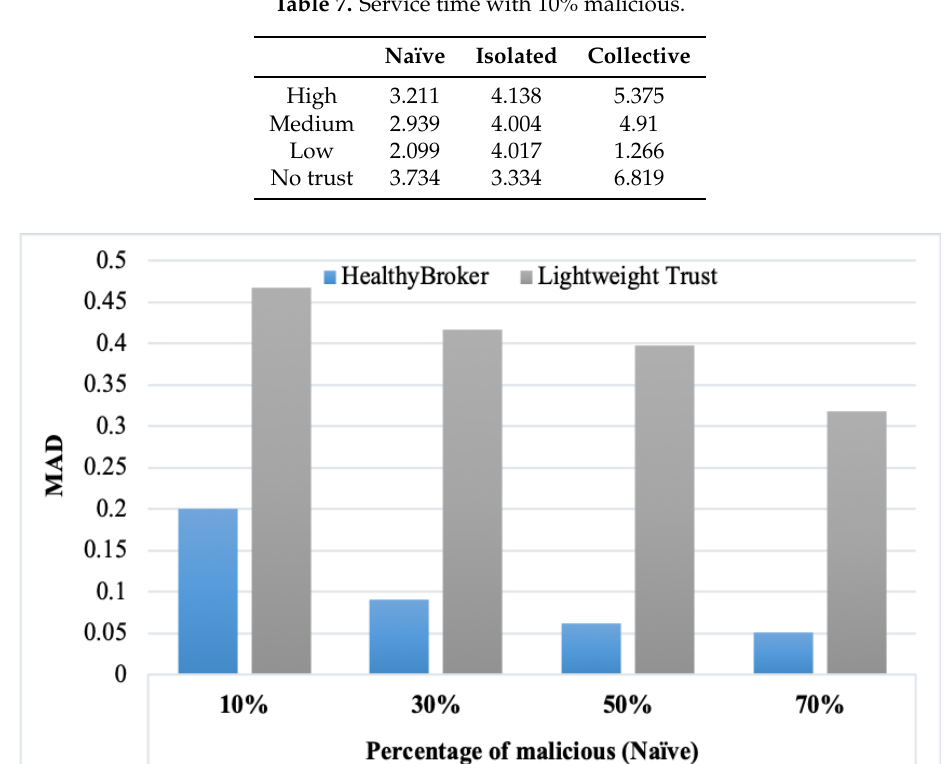
Figure 6. Mean absolute deviation (MAD) result with naïve malicious.